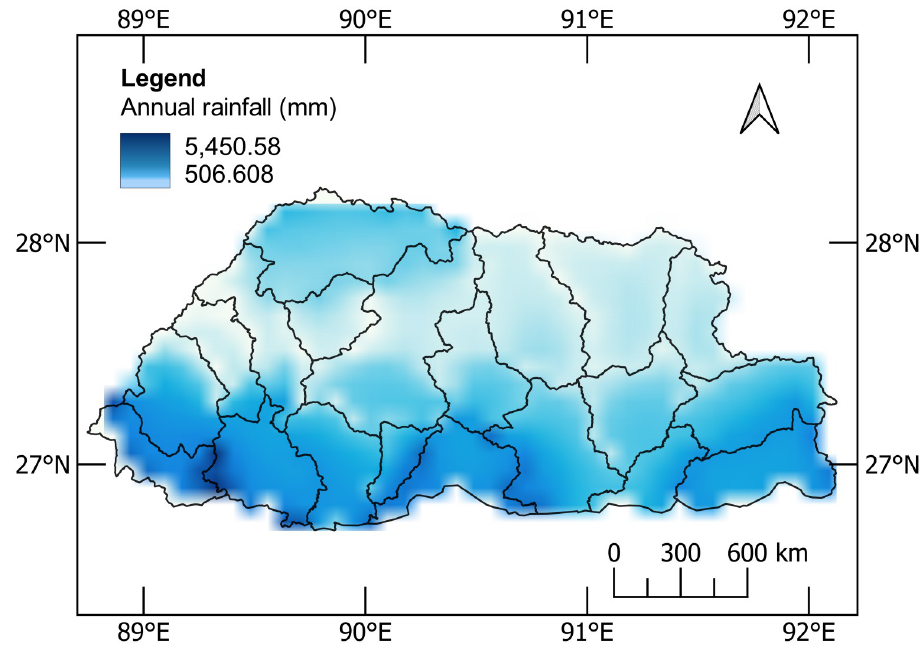
Fig 4. Spatial distribution of annual accumulated rainfall in 2020 against cumulative average rainfall between